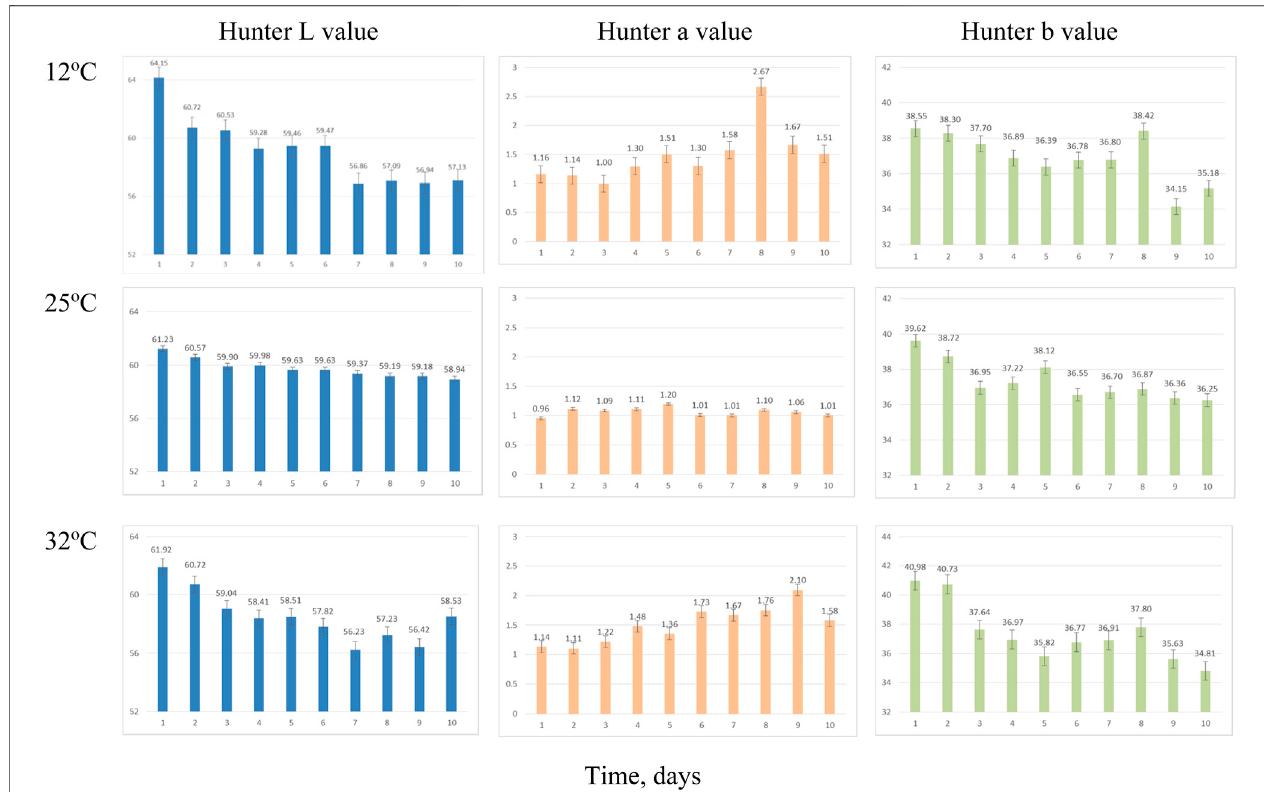
FIGURE 7 | Average Hunter color values change over time for whole stillage sampling due to incubation temperatures. Error bars denote 1 standard deviation.